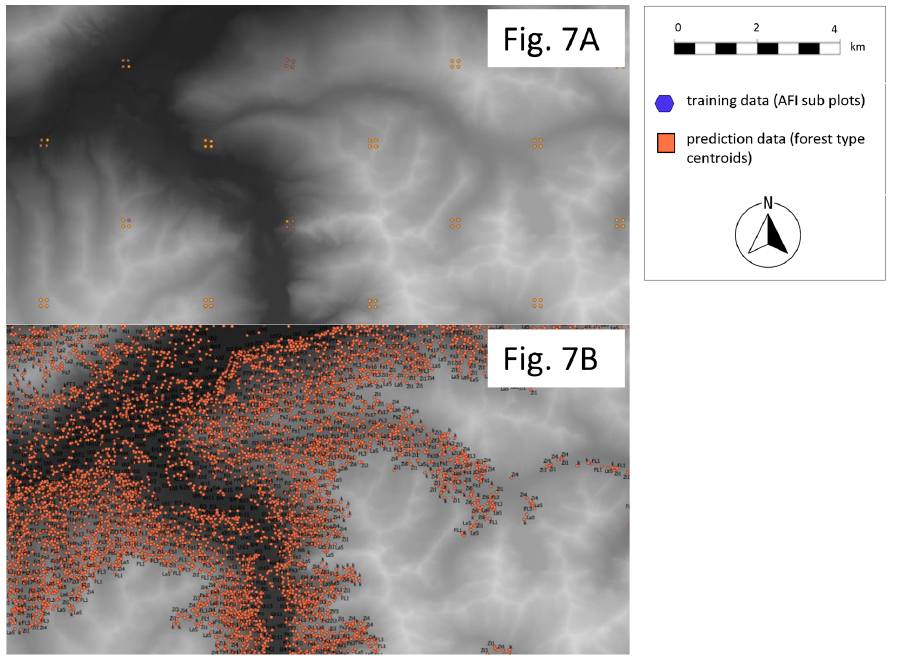
Figure 7. The training and prediction data set in R randomForest (47°15 ′ 34.7724 ″ N, 11°24 ′ 1.3500 ″ E). ( A ) The training set of AFI subplots. ( B ) The prediction set of forest typing polygon centroids for modeling ecosystem, species, genetic diversity, and biodiversity with R randomForest.